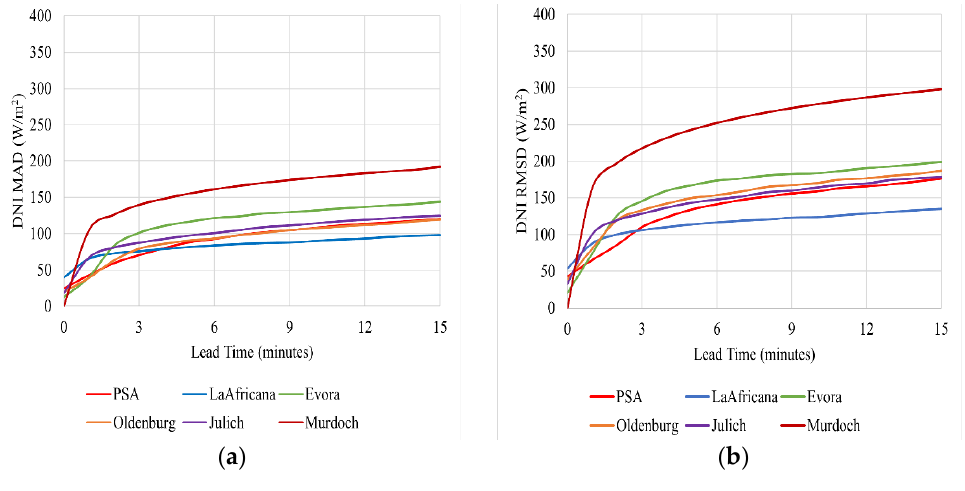
Figure 14. ( a ) Overall DNI MAD. ( b ) Overall DNI RMSD.